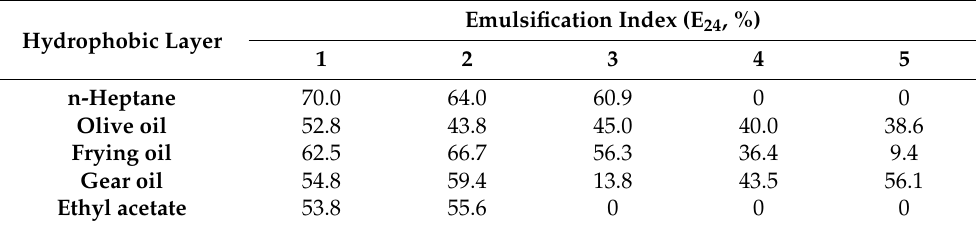
Table 2. Emulsifying activity (E 24 ) of the supernatants resulting from growth with different C-sources (1. used olive oil; 2. raw olive oil; 3. used frying oil and 4. glycerol) against n-heptane, olive oil, Frying oil, Gear oil, and ethyl acetate as organic phase. Ultrapure water was used as a negative control